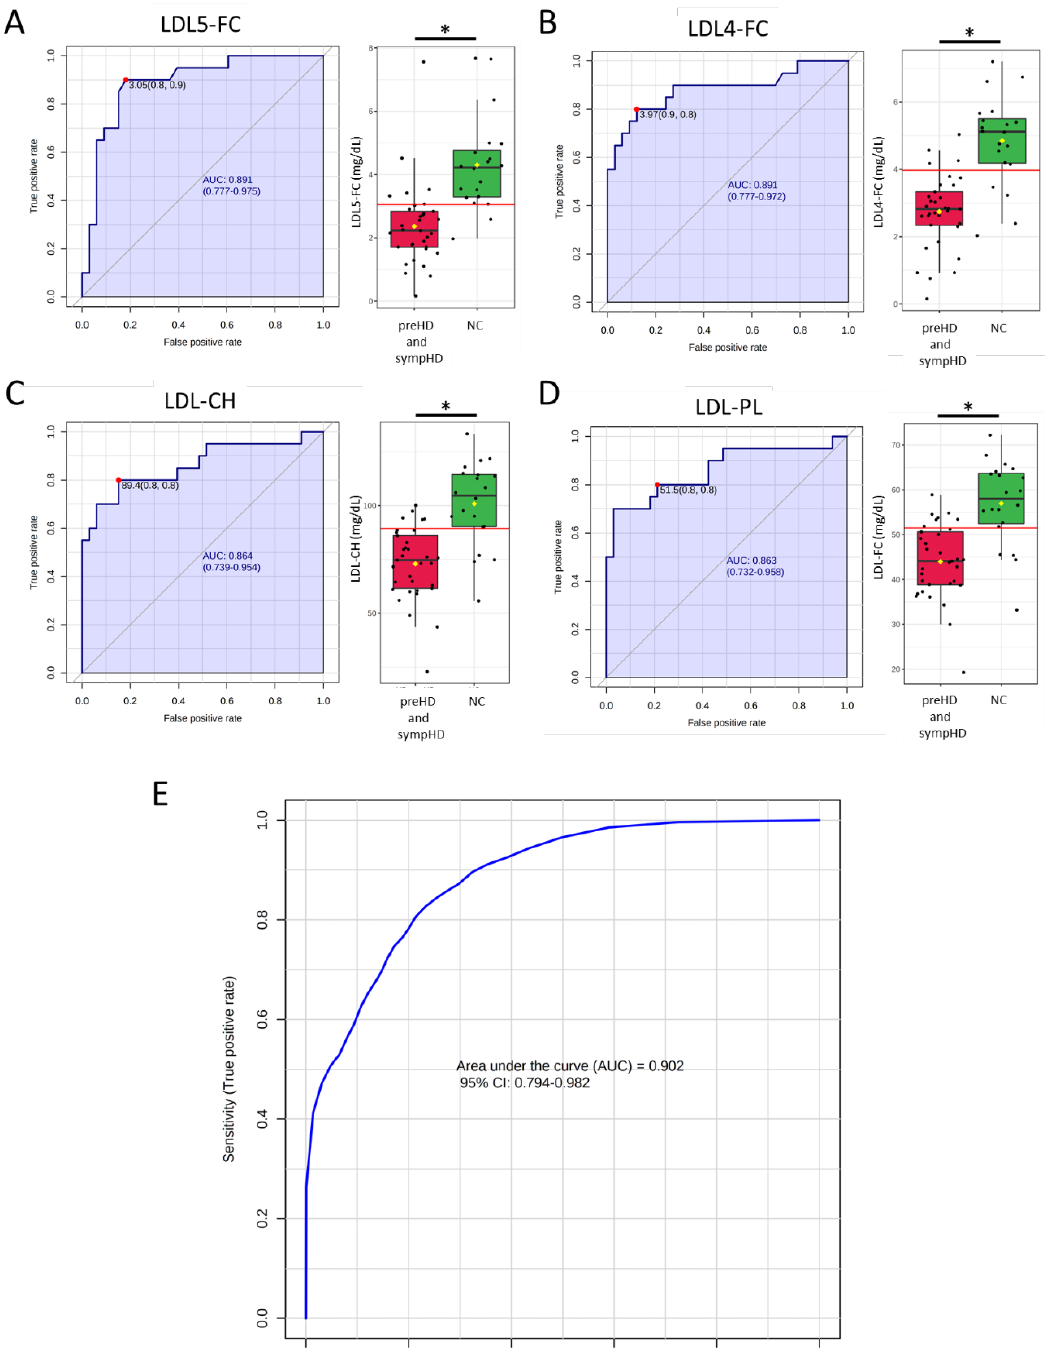
Figure 3. The receiver operating characteristic (ROC) curve and the box plot for plasma levels of ( A ) LDL5-FC, ( B ) LDL4-FC, ( C ) LDL-CH and ( D ) LDL-PL. Area under the ROC curve (AUC) was shaded. The black center line in the box plot indicated the median, while the red or green boxes represented the 25th to 75th percentiles. The black whiskers marked the 5th and 95th percentiles, and mean values were represented by yellow diamonds. The red dots and lines denoted the optimal cut-off. *: Statistically significant between two groups, p < 0.05, Mann–Whitney U test. ( E ) ROC analysis of the above four lipoprotein components using support vector machine. CH, total cholesterol; FC, free cholesterol; LDL, low-density lipoprotein.